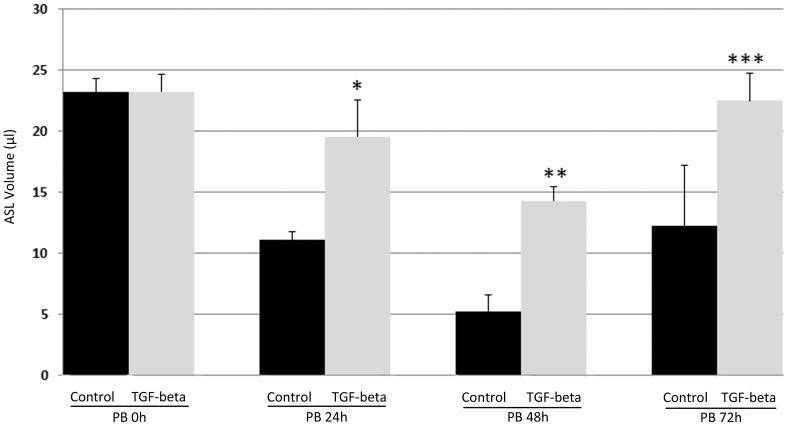
TGF-beta disruption of airway surface liquid (ASL) regulation in HAECs.Polarized non-CF HAECs had apical fluid removed, and the apical surface was then bolused with 20 µl of media. Cells were treated with vehicle (control) or TGF-beta (10 ng/ml), and the ASL volume was measured at 0, 24, 48, and 72 h post bolus (PB). TGF-beta or vehicle (diluted in water) was added to the to the apical bolus media at time  =  0, and to the basolateral media at time  =  0, 24 and 48 hours. N = 6. *P = 0.02 (control vs TGF-beta); **P = 0.00043 (control vs TGF-beta); ***P = 0.07 (control vs TGF-beta).